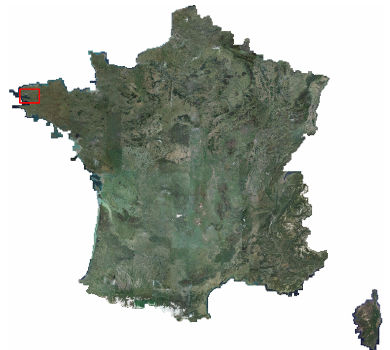
Figure 5. SPOT 6/7 coverage of France in 2014 - Red frame is